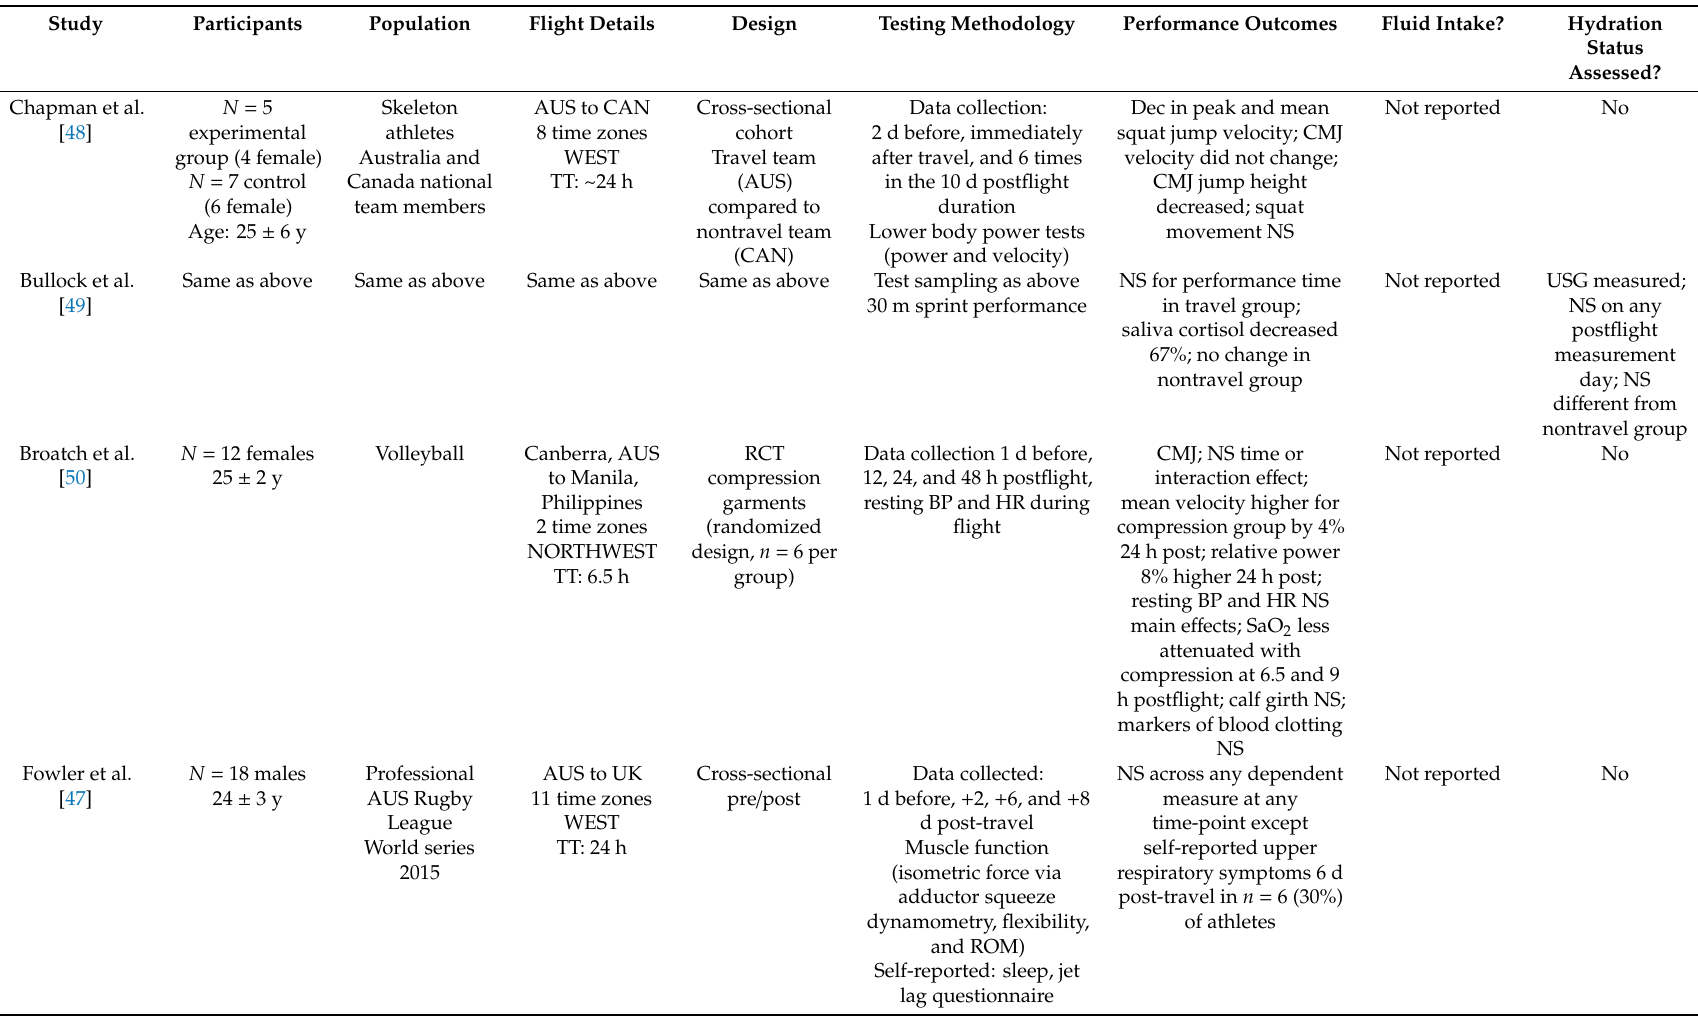
Table 2. Summary of the physiological e ff ects of jet lag and transmeridian travel on actual athletes traveling across multiple time